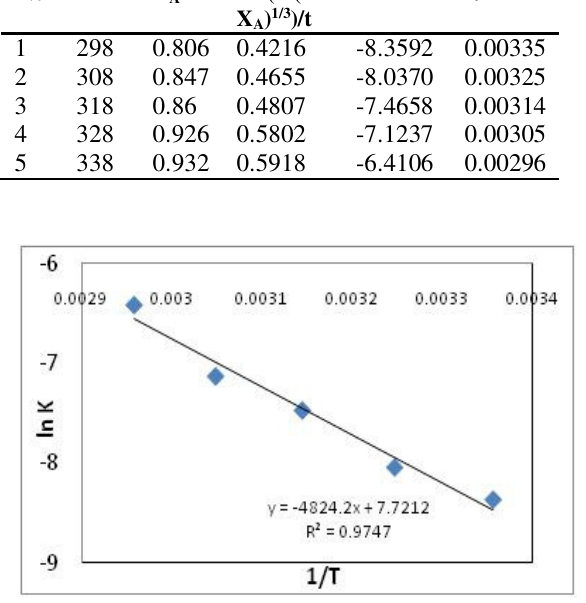
Fig. 7.Arrhenius plot using lactic acid at reaction conditions (Acid concentration=10 wt%, L/S=5